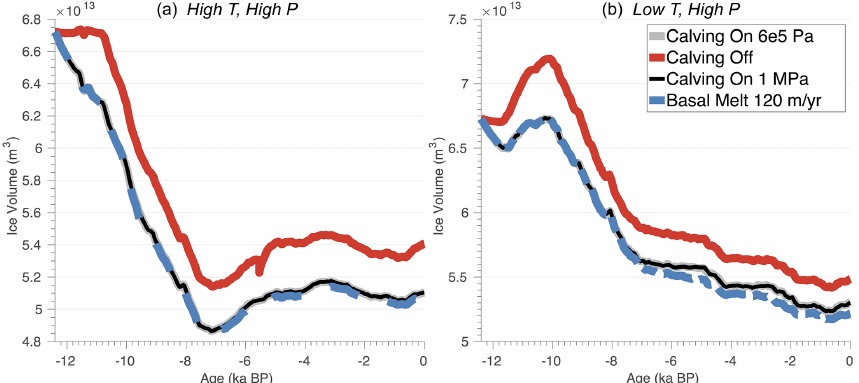
Figure 12. Sensitivity to the calving stress threshold for grounded ice and basal melt rates on floating ice. Red line: ice volume evolution for the simulations for which the calving parameterization was turned off. Black line: ice volume evolution for the simulations for which the calving stress threshold for grounded ice is 1MPa. Gray line: ice volume evolution for the simulations for which the calving stress threshold for grounded ice is 6kPa. Dashed blue line: ice volume evolution for the simulations for which the basal melt rate on floating ice was set to 120myr − 1 (with calving stress threshold for grounded ice =